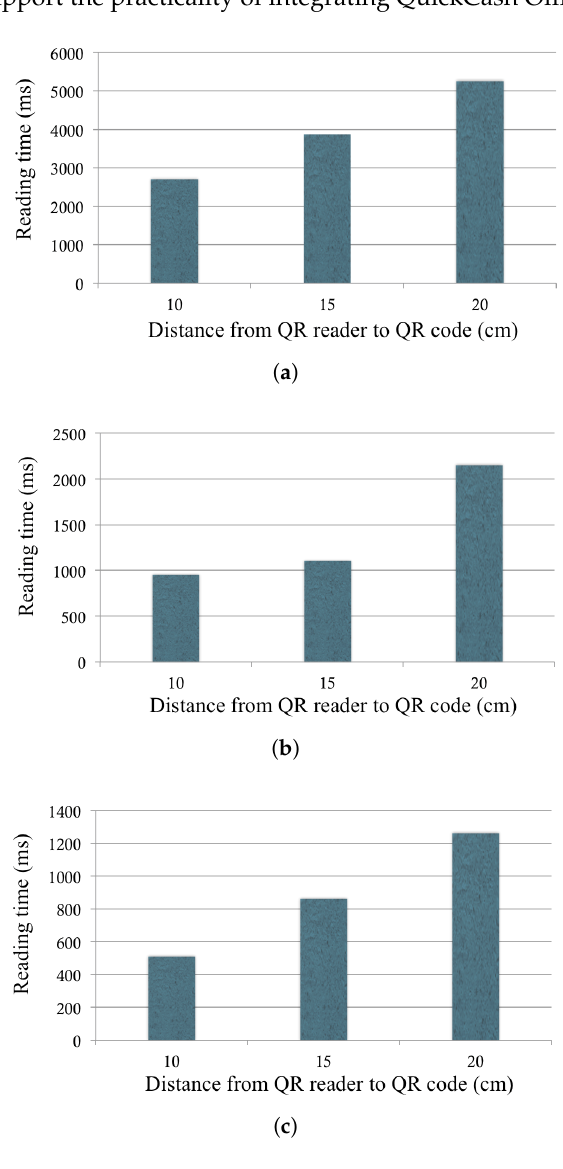
Figure 10. The time to read a QuickCash Offline transaction: ( a ) The reading time for iPhone 4; ( b ) The reading time for iPhone 5; ( c ) The reading time for iPhone